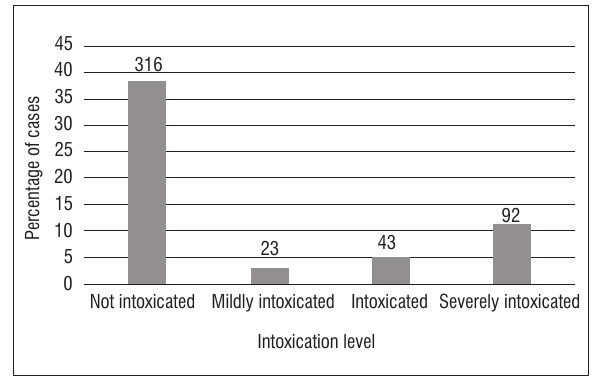
Percentage distribution of the blood alcohol concentration levels in victims of blunt force